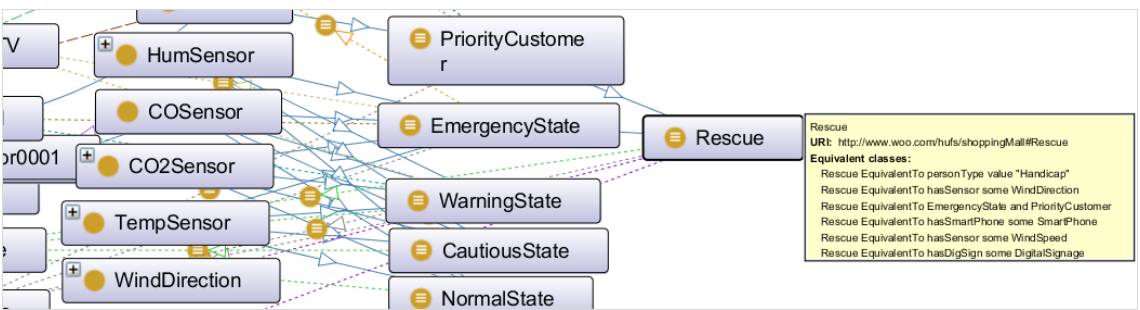
Figure 21. Instances: representation of VOs in the semantic ontology.